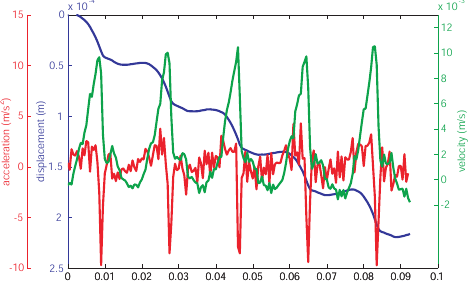
Figure 5. Initial particle motion for ballotini on perspex at dif- ferent heights (plotted on the right hand axis). Little slip-stick motion is observed at 0.8m and below. Note also that particles at the top of the tube initially move faster, as seen in the varying gradient: u a = 6 . 58 mms − 1 for H c = 1.1m to u a = 3 . 72 mms − 1 for H c =